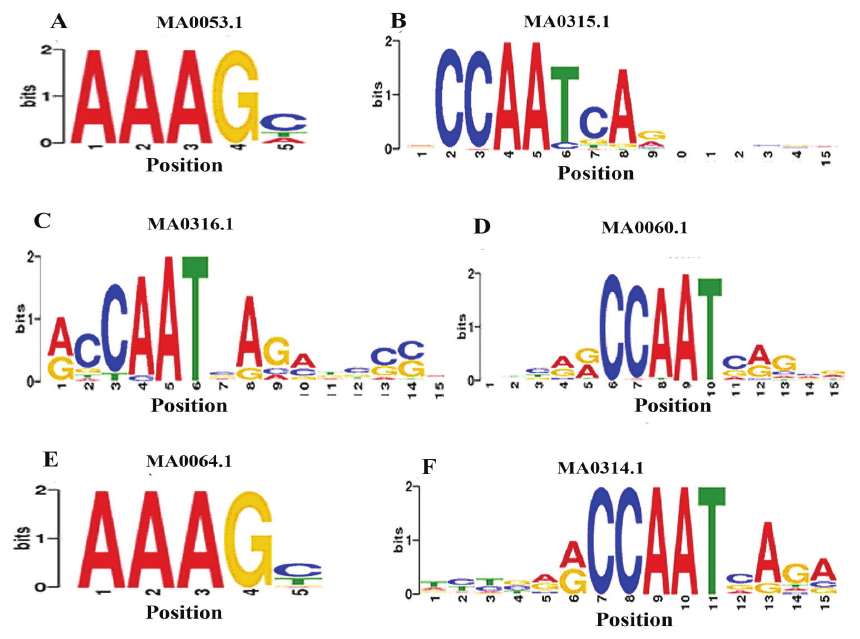
Figure 6. Overrepresented sequences in the bidirectional promoters of geminiviruses used in this study. Letters abbreviating the nucleotides (A, C, G, T) in the images are sized to their relative occurrence. ( A ) MNB1A motif (MA0053.1) p -value 3.1e-075 belongs to Zinc-coordinating class and Dof family; ( B ) HAP4 motif (MA0315.1) p -value 4.2e-027; ( C ) HAP5 motif (MA0316.1) p -value 7.33e-05; ( D ) NFYA motif (MA0060.1) p -value 5.3e-06; ( E ) PBF motif (MA0064.1) p -value 1.4e-017 belongs to Zinc-coordinating class and Dof family; ( F ) HAP3 motif (MA 00314.1) p -value 1.2e-07. All HAP motifs belong to Alpha Helix class and NFY CCAAT-binding